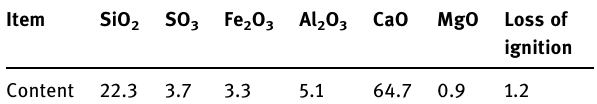
Table 1: Chemical composition of cement ( % )